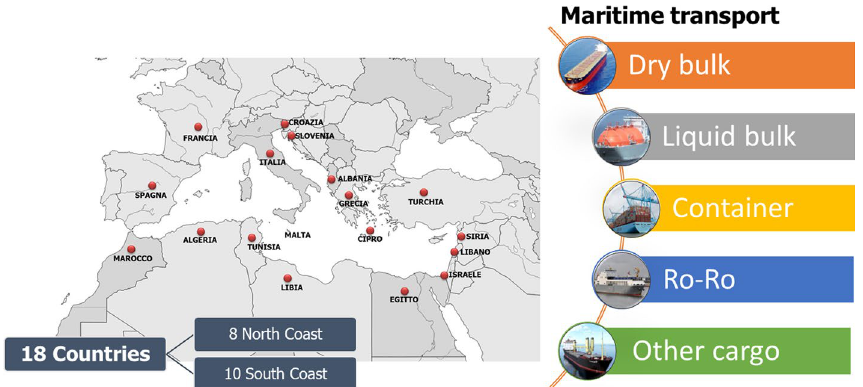
Fig. 1 Context of model